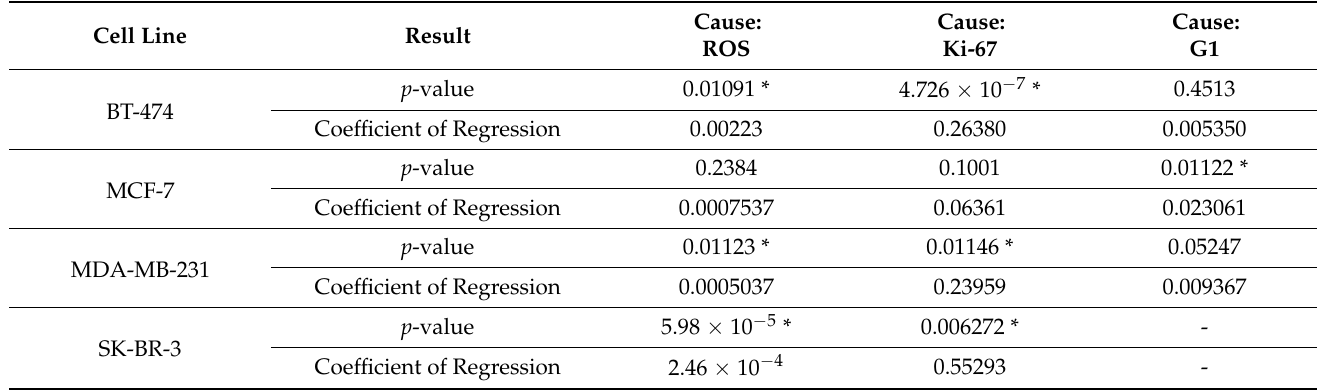
Table 5. p -values and coefficients of linear regression for all cell death models for cells treated for 5 min (* p < 0.05).